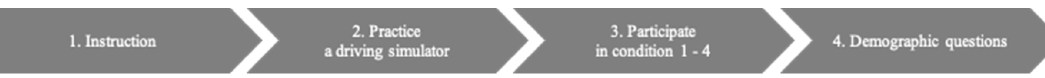
Figure 14. The case study procedure (Source: Own creation).